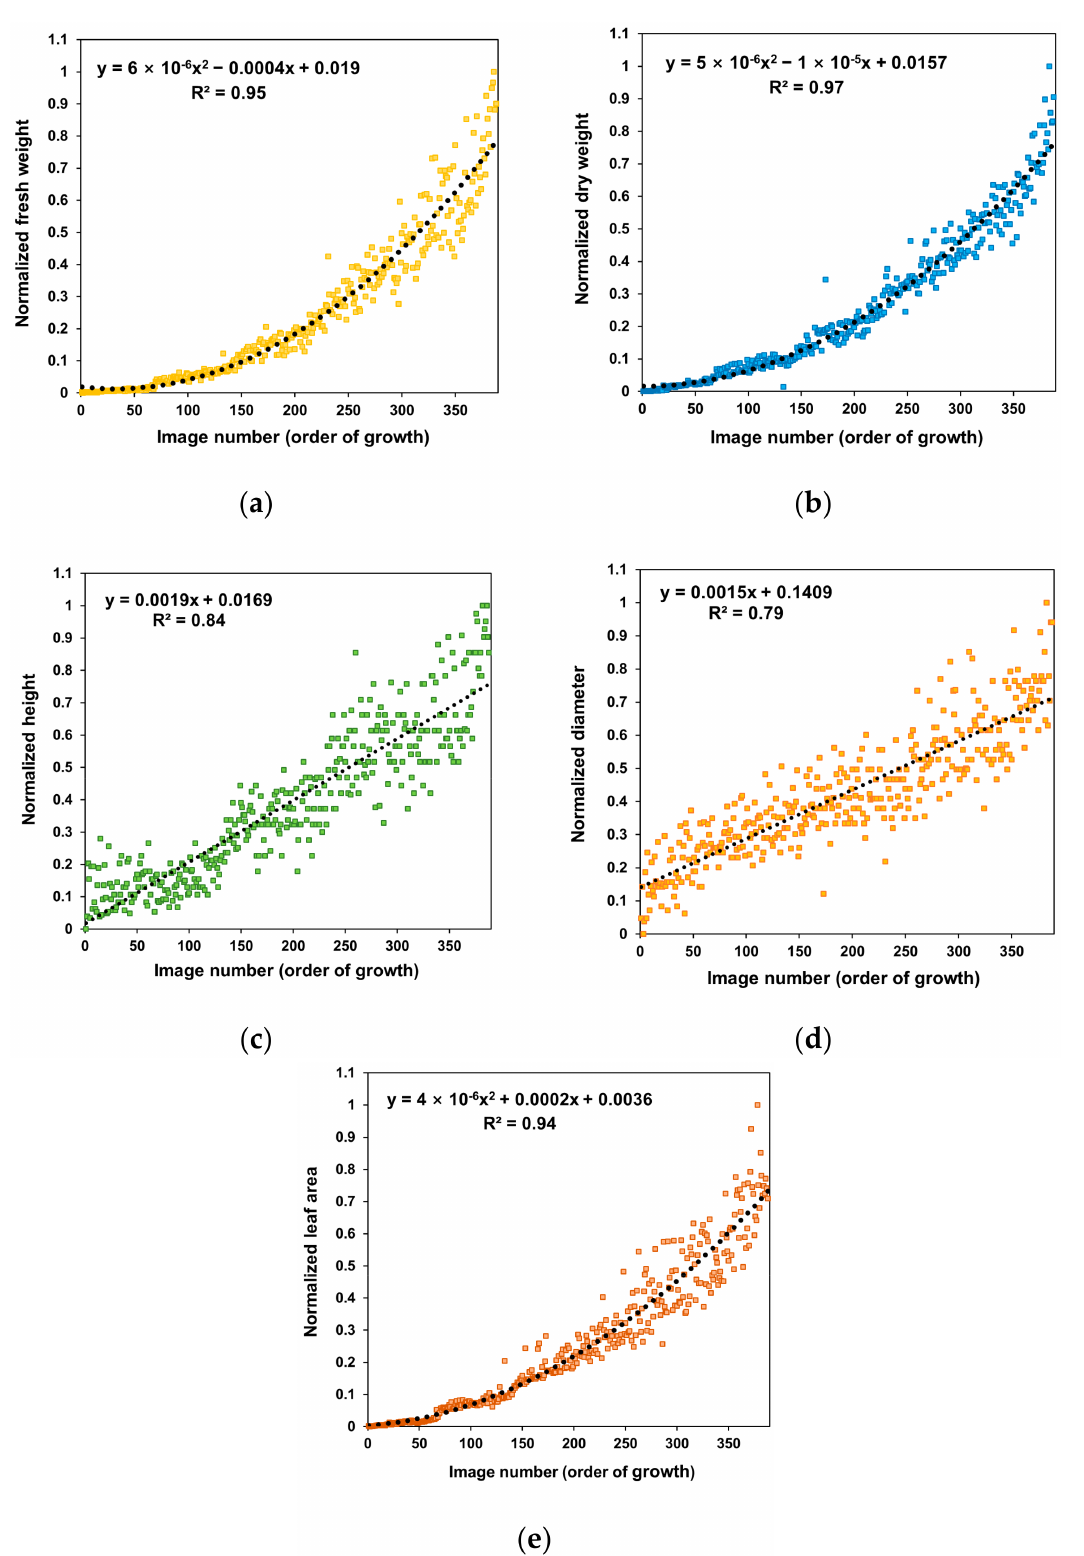
Figure 3. Change rates of growth indices in the dataset according to the crop growth ordered as the largest normalized growth index effect obtained from the product of each index: ( a ) fresh weight, ( b ) dry weight, ( c ) height, ( d ) diameter, and ( e ) leaf